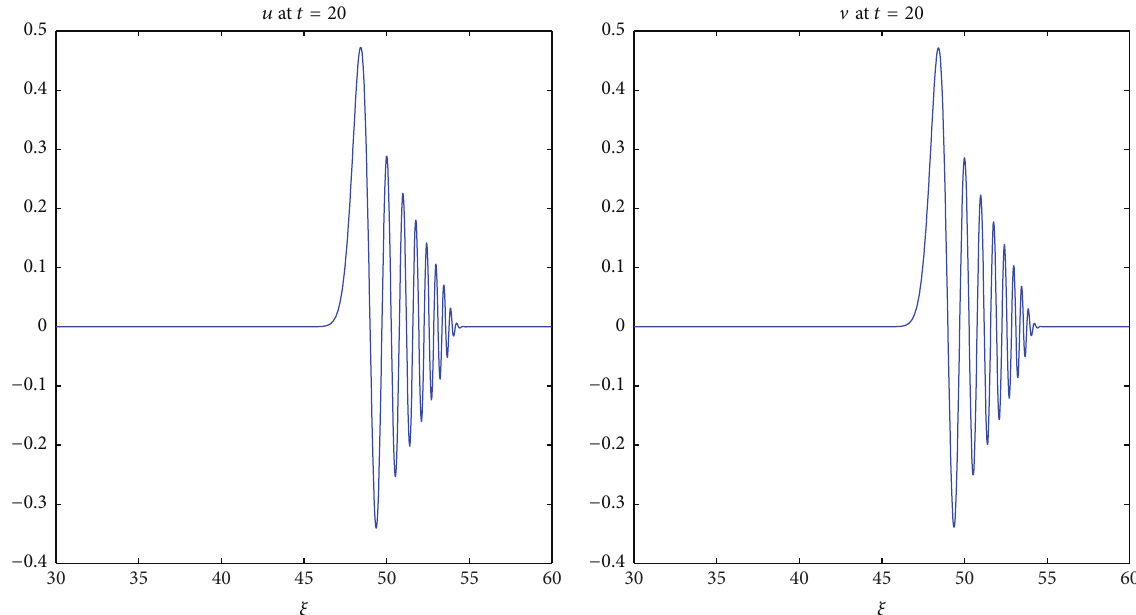
Figure 12: Evolution of a Gaussian pulse over a flat channel with surface tension effect. Parameters: 𝛼 = 0 , 𝛽 = 0.01 , and 𝜎 = 0.6 .